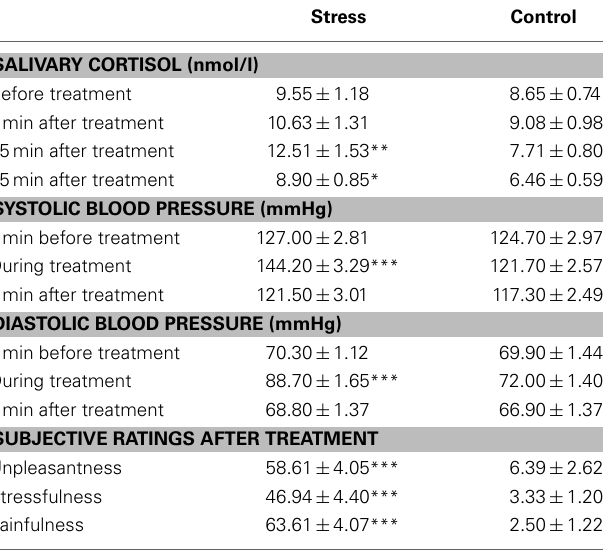
responses to as well as subjective ratings of the SECPT vs. control